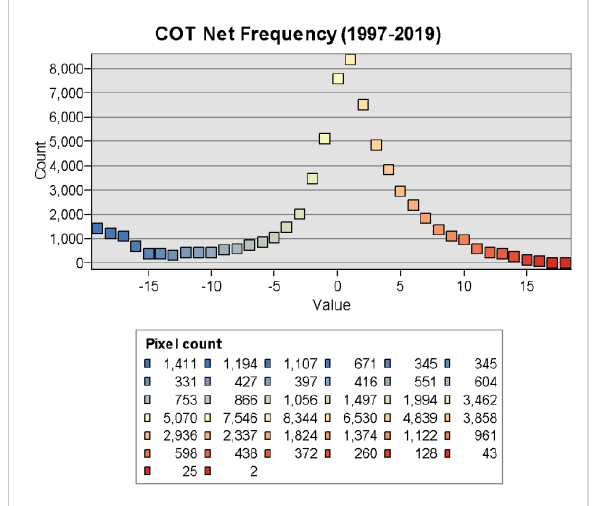
Figure 3. Grid cell (pixel) value vs count of output net frequency of cluster and outlier type (COT) in Metro Manila for 1997 to 2019.